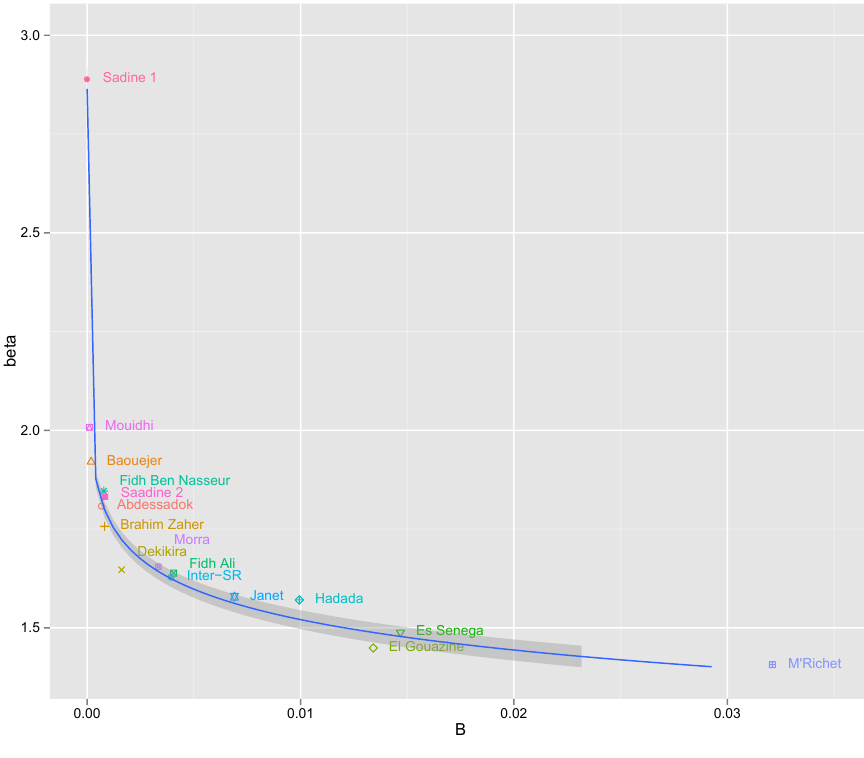
Figure 7. B and β parameters for each of the 15